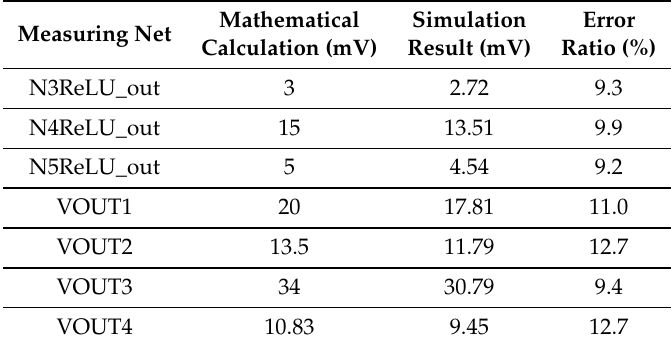
Table 2. Evaluation to our MLP